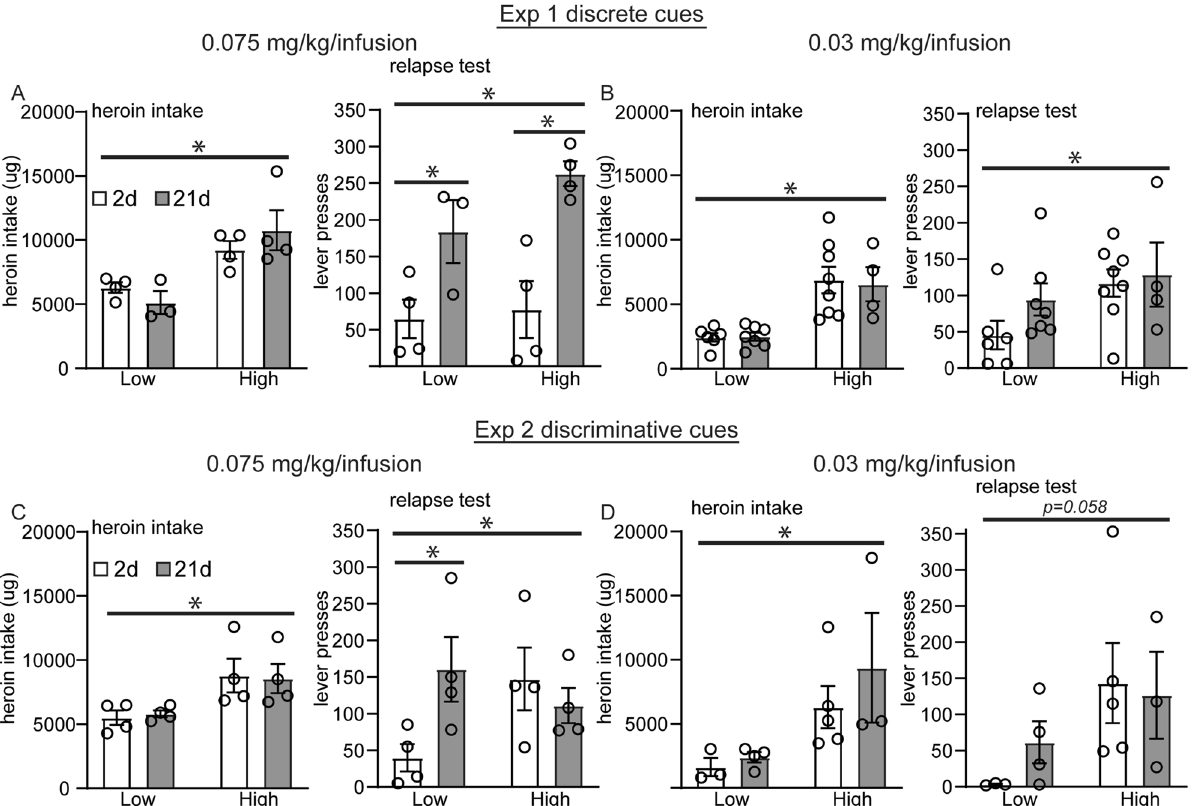
Figure 5. Variability in total drug intake contributes to incubation of craving for discriminative but not discrete drug cues at a 0.075 mg/kg/infusion dose. In each experimental protocol, some animals self-administered high total heroin intake or lower amounts of total heroin intake. Animals were classified as high or low heroin takers based on whether they were above or below the median total heroin intake for their experimental protocol. Shown are the average amounts of total heroin intake over 10 days of heroin self-administration as well as active lever pressing during a 90 min relapse test at 2 or 21 days after the last drug session for experiment 1 with discrete drug cues ( A , B ) and experiment 2 with discriminative drug cues ( C , D ). Error ± SEM. * p <